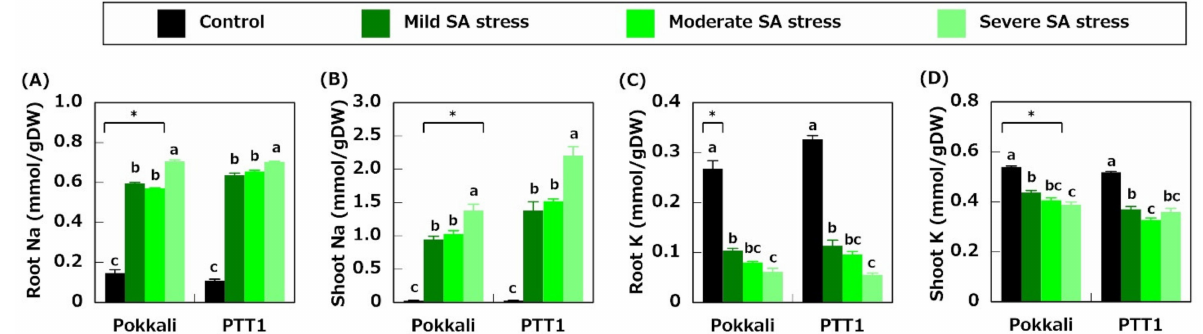
Figure 2. Effects of saline-alkaline stress (mild, moderate, and severe) on the Na concentration in the roots ( A ) and shoots ( B ) and the K concentration in the roots ( C ) and shoots ( D ) of Pokkali and PTT1. Data are the means of 4 replicates ± S.E. Similar letters indicate no significant differences between the treatments in each variety ( p < 0.05). Asterisks show significant differences between Pokkali and PTT1 in each treatment ( p < 0.05).